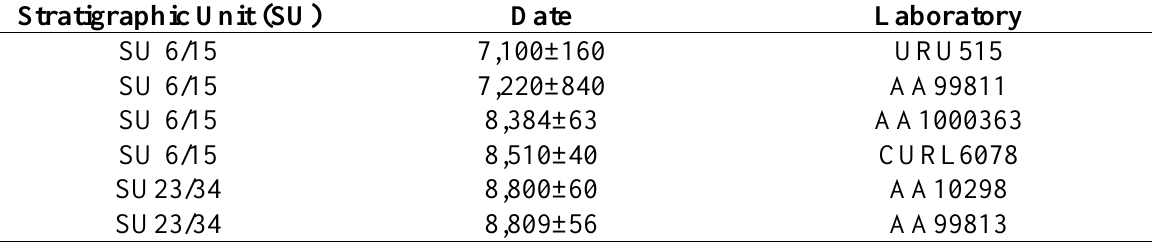
Table 1. Radiocarbon dates in year B.P. for the. Rincón de los Indios site. Stratigraphic Unit